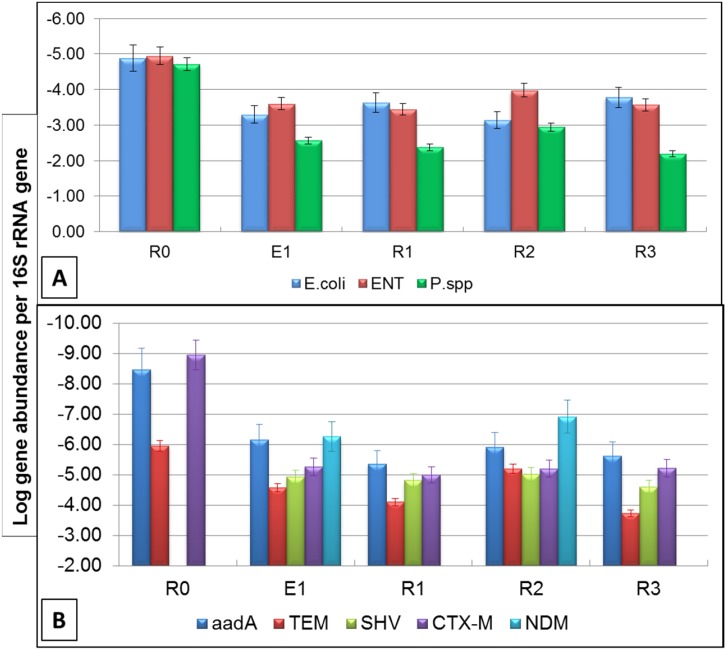
Gene copy number of (A) selected bacterial species (E. coli, ENT, and Pseudomonas spp.) and (B) selected antibiotic resistance genes (aadA, blaTEM, blaCTX‑M, blaSHV, and blaNDM) normalized to 16S rRNA gene copy numbers in the sediment samples collected in September 2013 from CRB, Tiruchirappalli, Tamil Nadu, India.